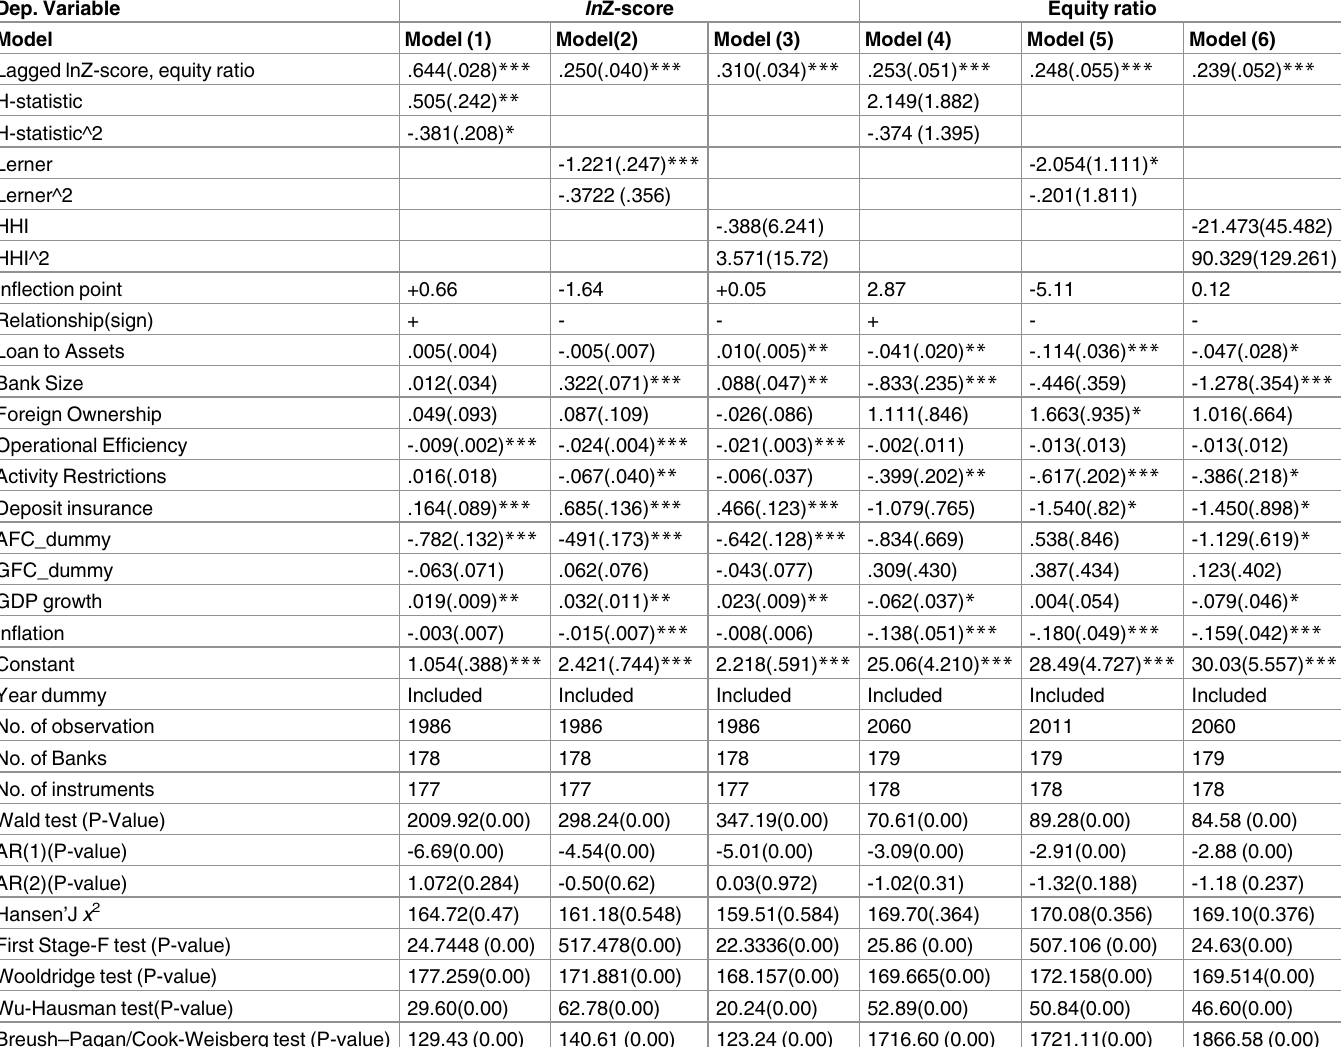
Table 4. The effect of competition measuredby H-statistic, Lerner index and HHI on ln Z-score and equity ratio as measureof financial stability in ASEAN-5 from 1990–2014 period. Dep.